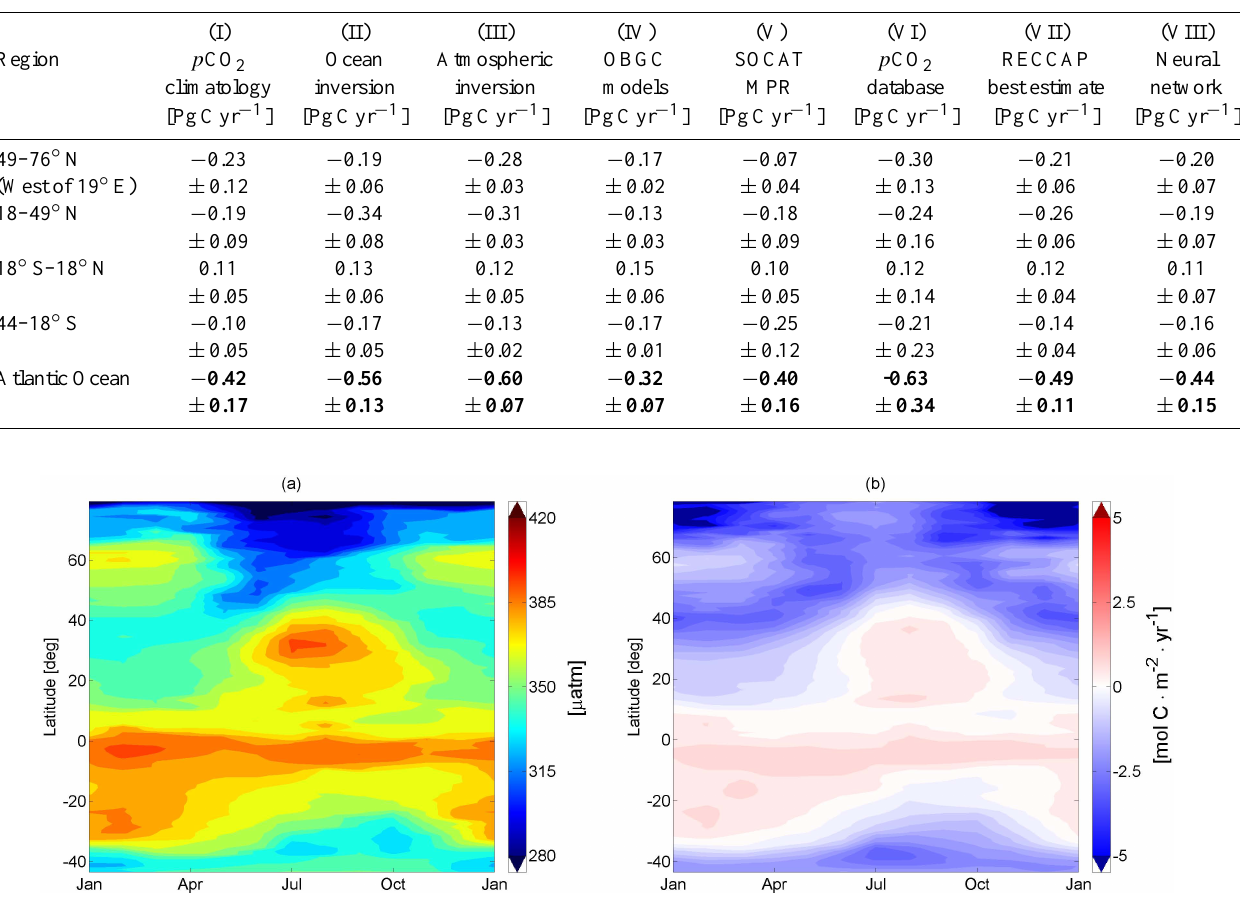
Fig. 8. Hovmöller plot of the zonally averaged long-term mean seasonal cycle of (a) p CO 2 in µatm and (b) the CO 2 flux density in molCm − 2 yr − 1